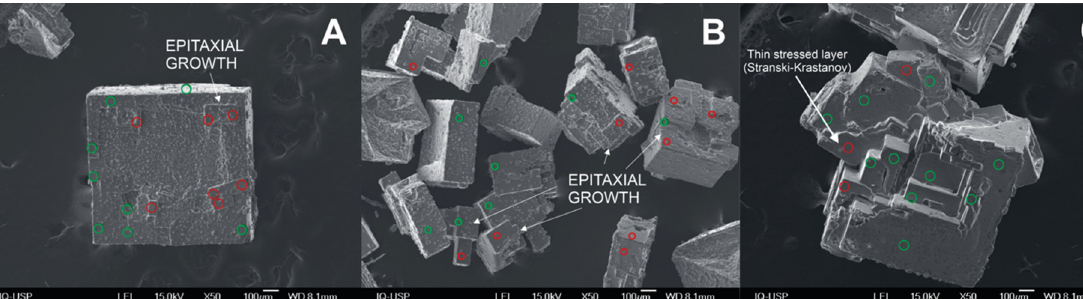
Figure 6. SEM image of: ( A ) NaCl seed grown, ( B ) crystals resulting from primary nucleation (not related to the seed) on the experiment seeded with NaCl, and ( C ) KCl seed grown after 60 min in the NaCl–KCl–H 2 O droplet under evaporation. Red and green circles represent the spots identified by EDS as KCl and NaCl, respectively.